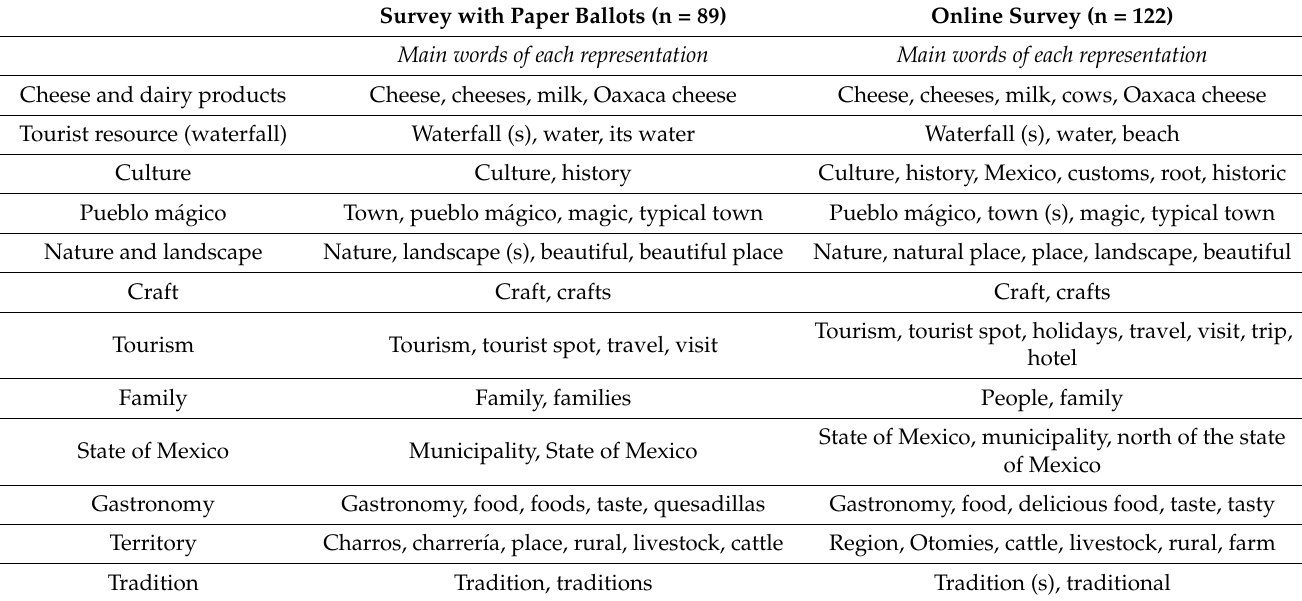
Table A1. Main words of the social representations identified in the two studies. Survey with Paper Ballots (n =